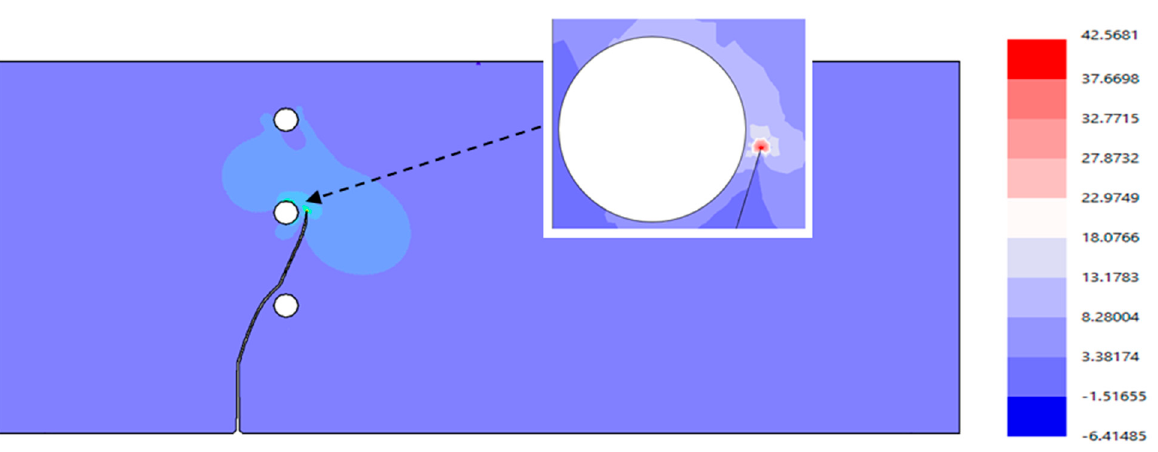
Figure 10. Maximum principal stress distribution of case I for the PMMA specimen.